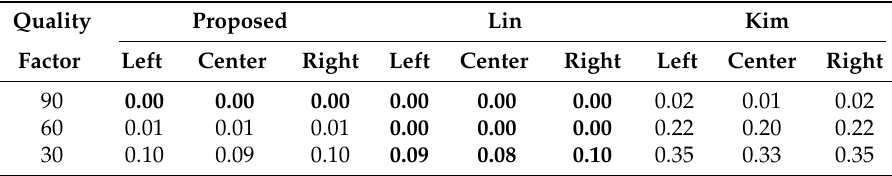
Table 8. Average BER for JPEG attack.